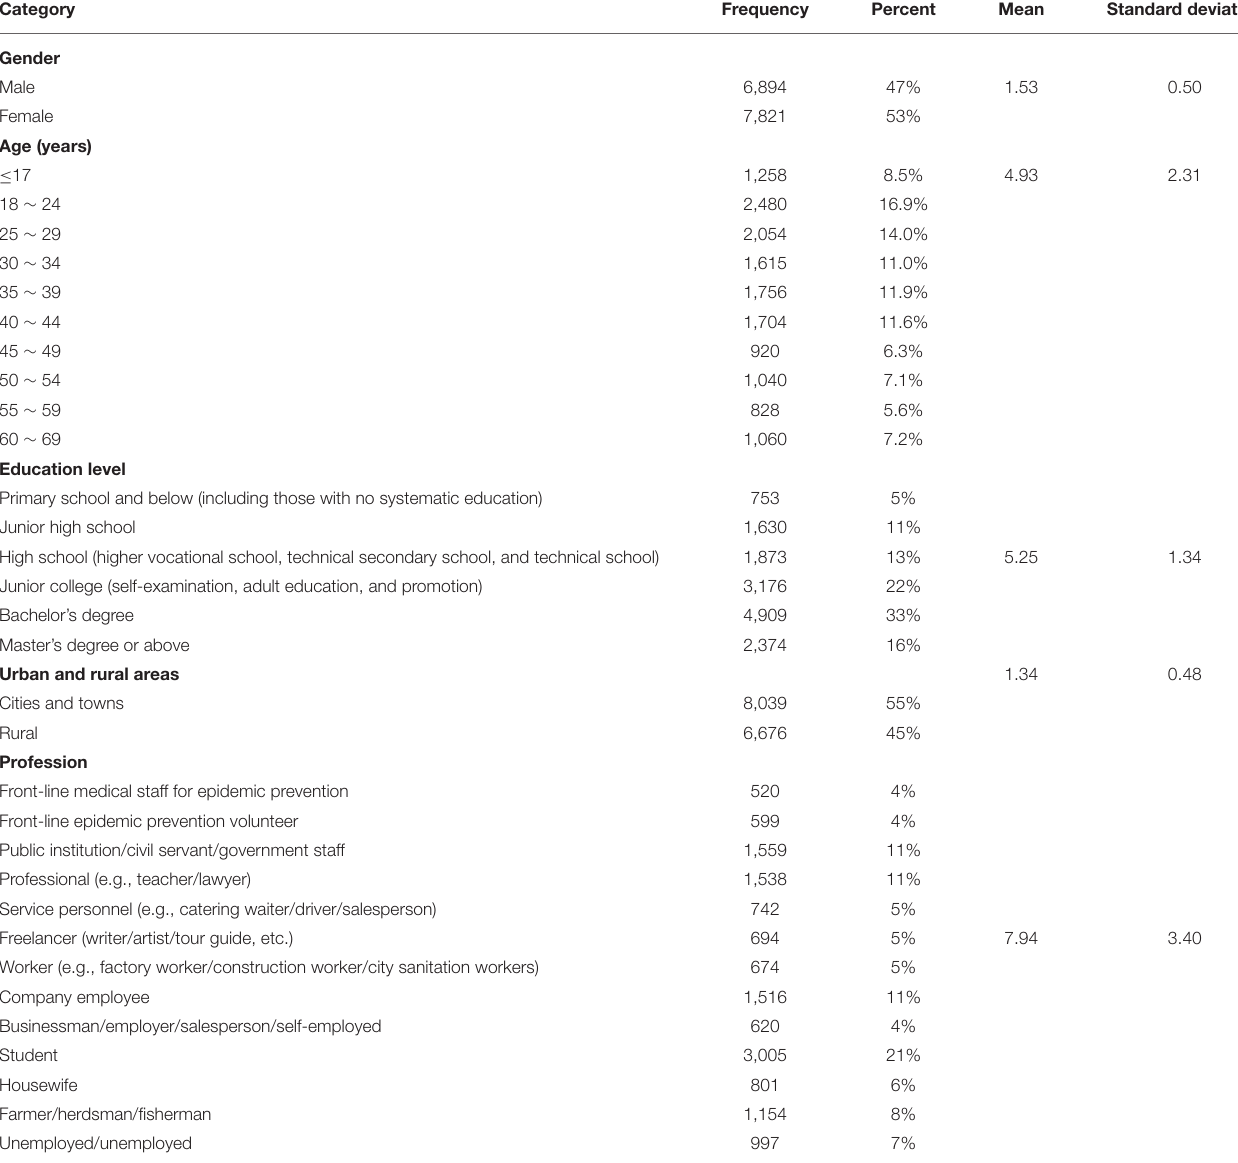
TABLE 1 | Basic characteristics of the respondents ( n = 14,715 participants).